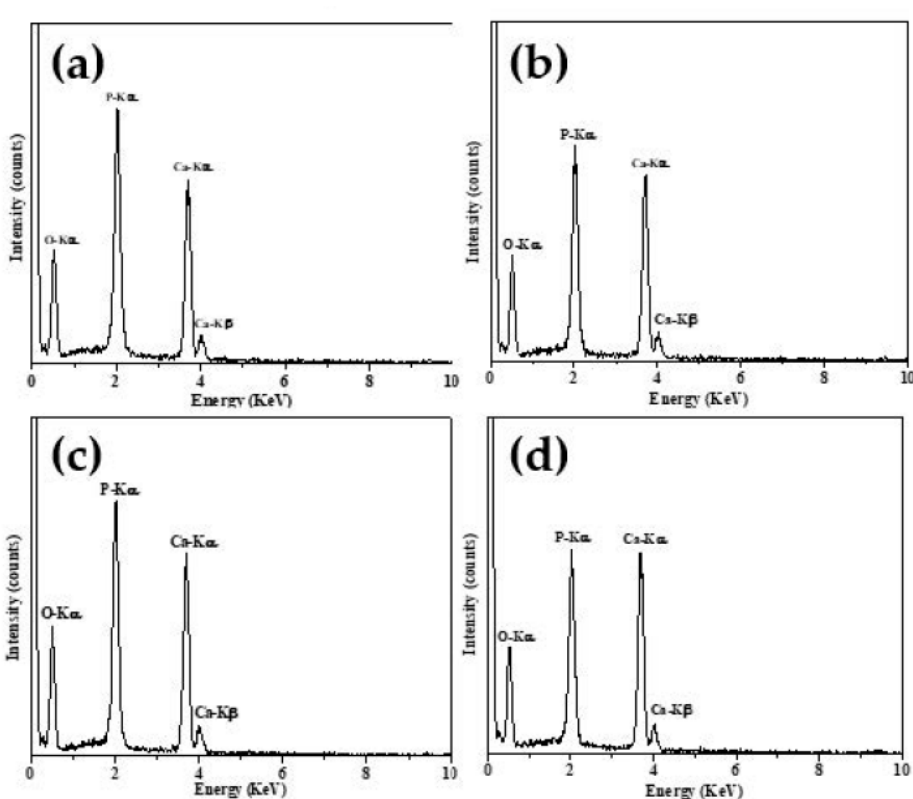
Figure 5. EDS spectra of β -TCP powders calcined at temperatures of ( a ) 800, ( b ) 900, ( c ) 1000, and ( d ) 1100 °C. Table 2. Atomic compositions of β -TCP powders calcined at temperatures of 800, 900, 1000, and 1100 °C derived from EDS spectra.